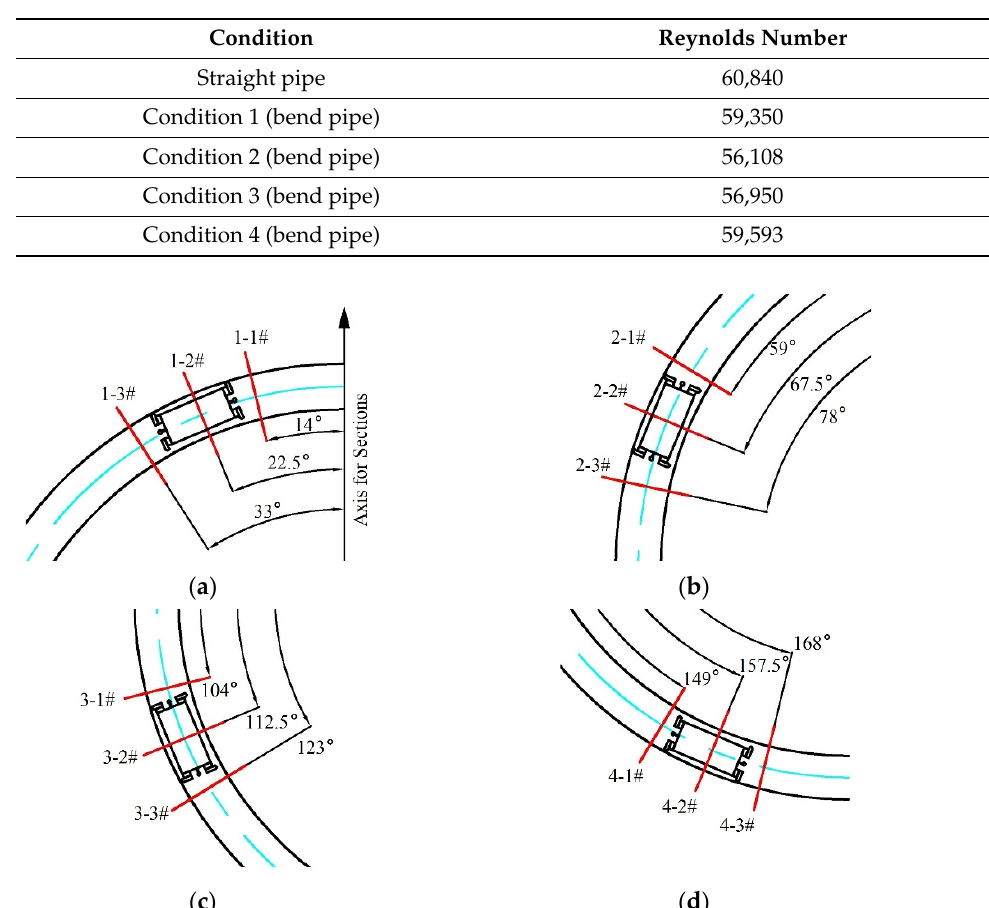
Figure 4. Analysis section layout: ( a ) location θ = 22.5° (first condition); ( b ) location θ = 67.5° (second condition); ( c ) location θ = 112.5° (third condition); ( d ) location θ = 157.5° (fourth condition). The symbols # are the marks of sections; the red lines are the locations of sections; the blue lines are the axis of the pipeline. Table 2. Threshold of motion Reynolds numbers for different conditions.